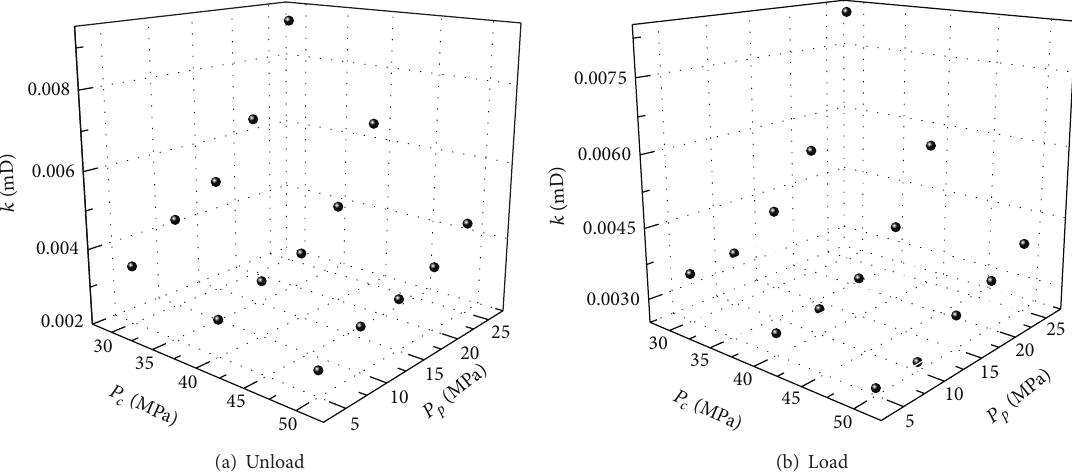
Figure 9: Permeability versus pore pressure and confining pressure measured by brine when unloading (a)/loading (b) the pore pressure under three different confining pressure conditions.